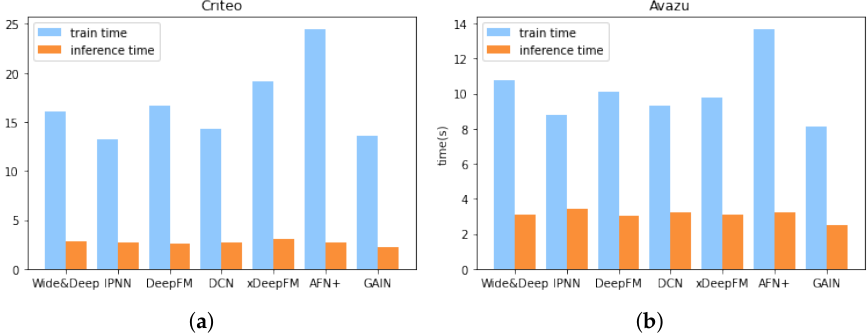
Figure 3. Training and inference time for 100 batches (batch size = 2000) of different models. ( a ) Comparison on Criteo. ( b ) Comparison on Avazu.